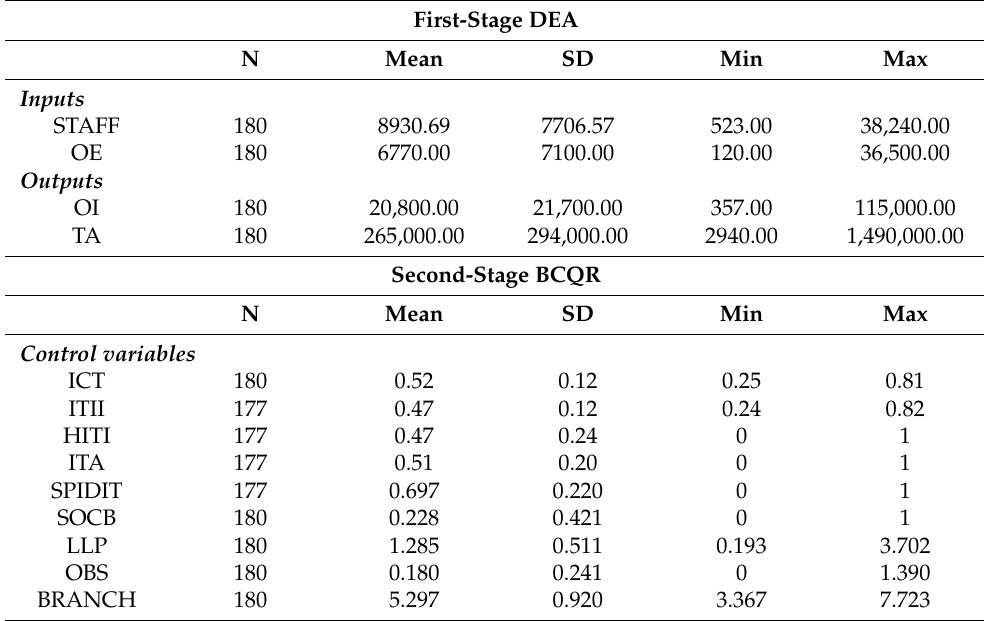
Table 1. Descriptive statistics of variables used in this